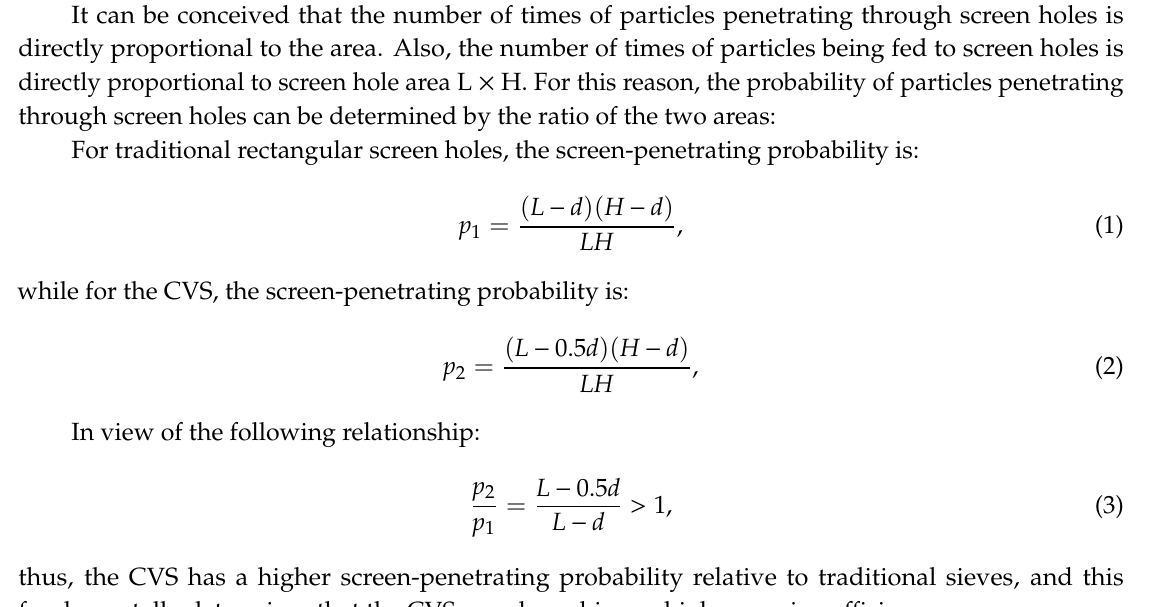
Figure 2. Schematic diagram of particles passing through screen holes of ( a ) a traditional rectangular screen and ( b ) a CVS.